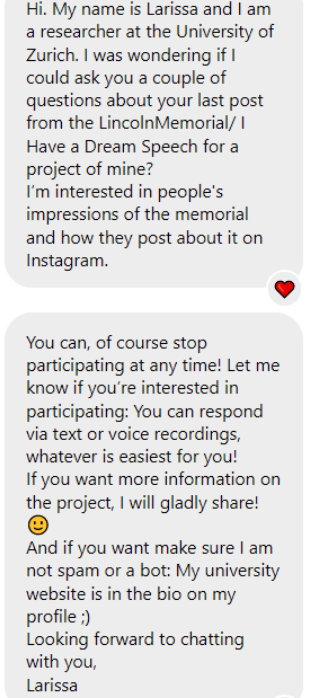
Figure 5. First interaction.